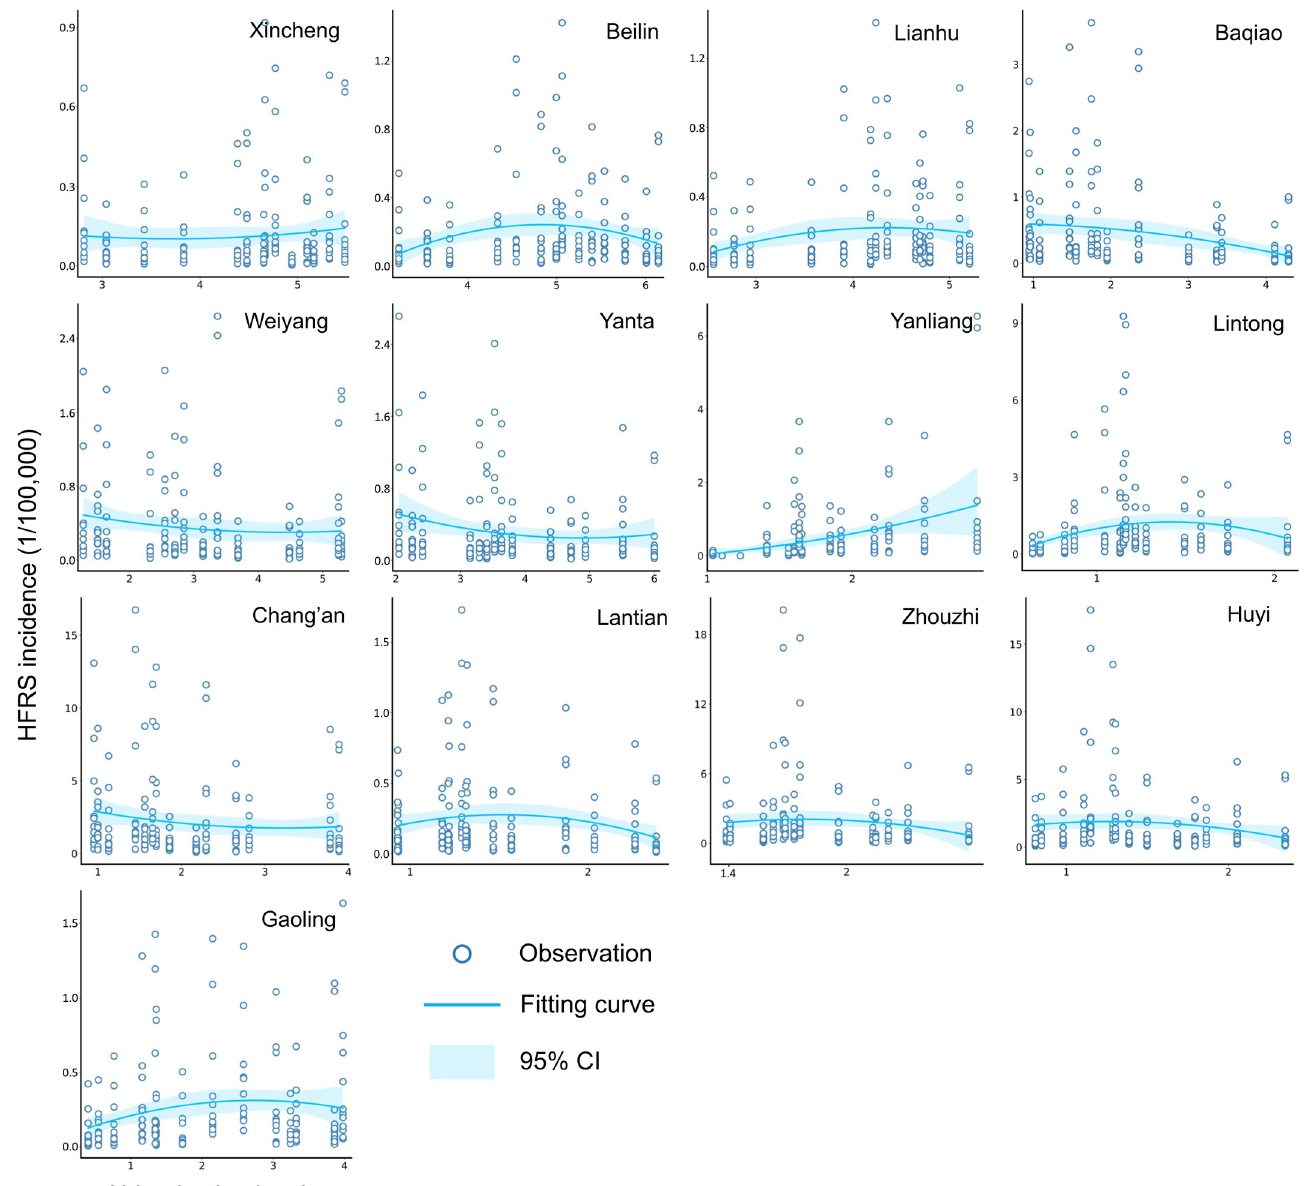
Fig 6. Scatter plot between incidence rate and urbanization level for 13 counties and districts of Xi’an City.